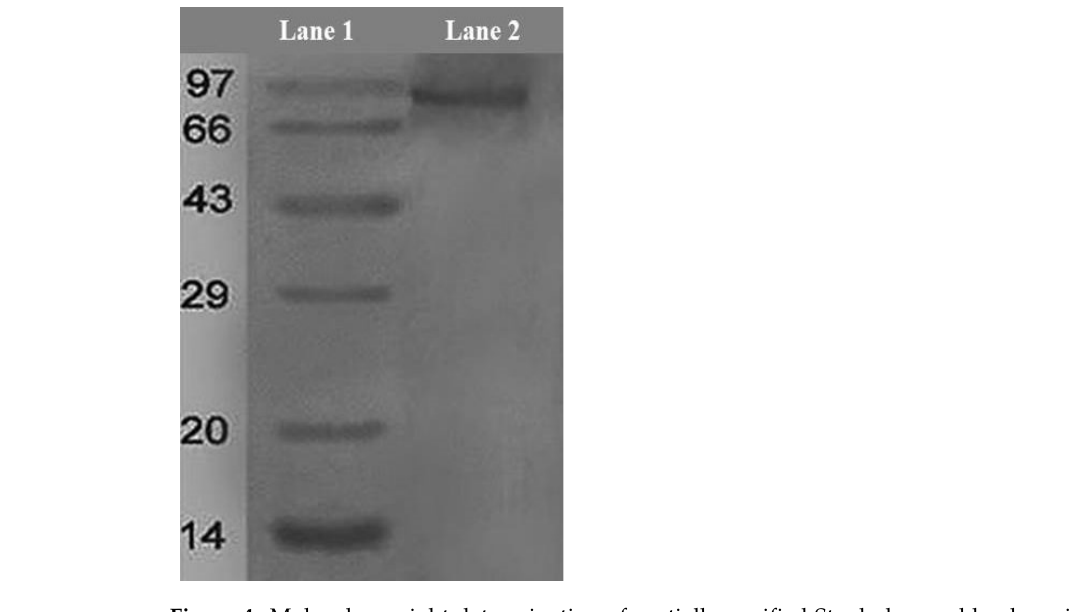
Figure 4. Molecular weight determination of partially purified Staphylococcal hyaluronidase en- zymes by SDS-PAGE analysis Lane 1: molecular weight standard protein; Lane 2: Staphylococcal hyaluronidase resulted from purification.